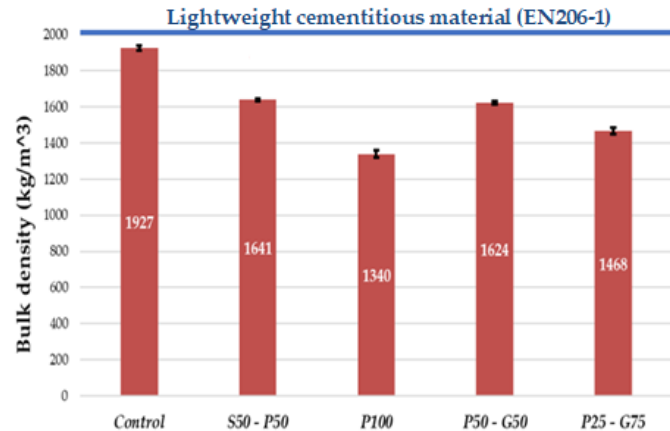
Figure 11. Bulk density of the all printable cement mortars.